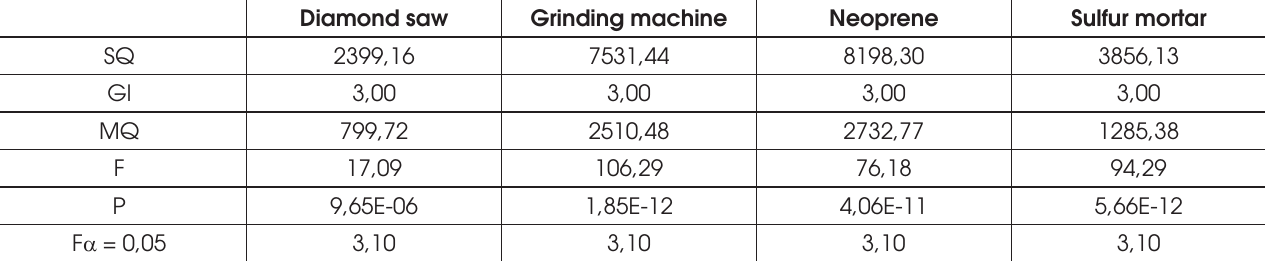
ANOVA results for the 4 surface preparation systems evaluated for the four mixes of concrete